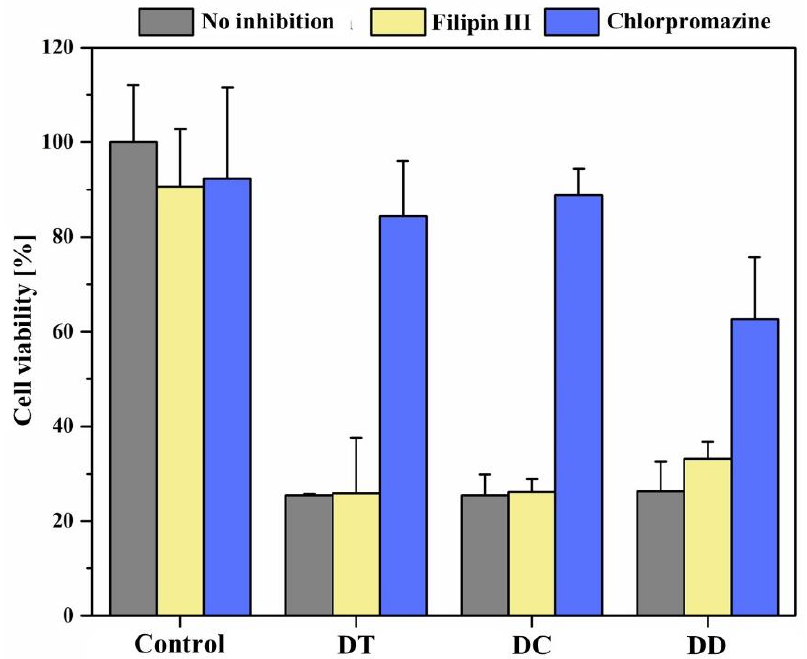
Figure 7. Determination of the endocytotic uptake mechanism of nebulised curcumin liposomes after irradiation with a fluence of 6.61 J cm −2 at λ = 457 nm. The endocytosis pathways were either inhibited by filipin III or chlorpromazine or were not inhibited. The incubation time of liposomes was 4 h, and untreated cells represented the 100% value of cell viability.